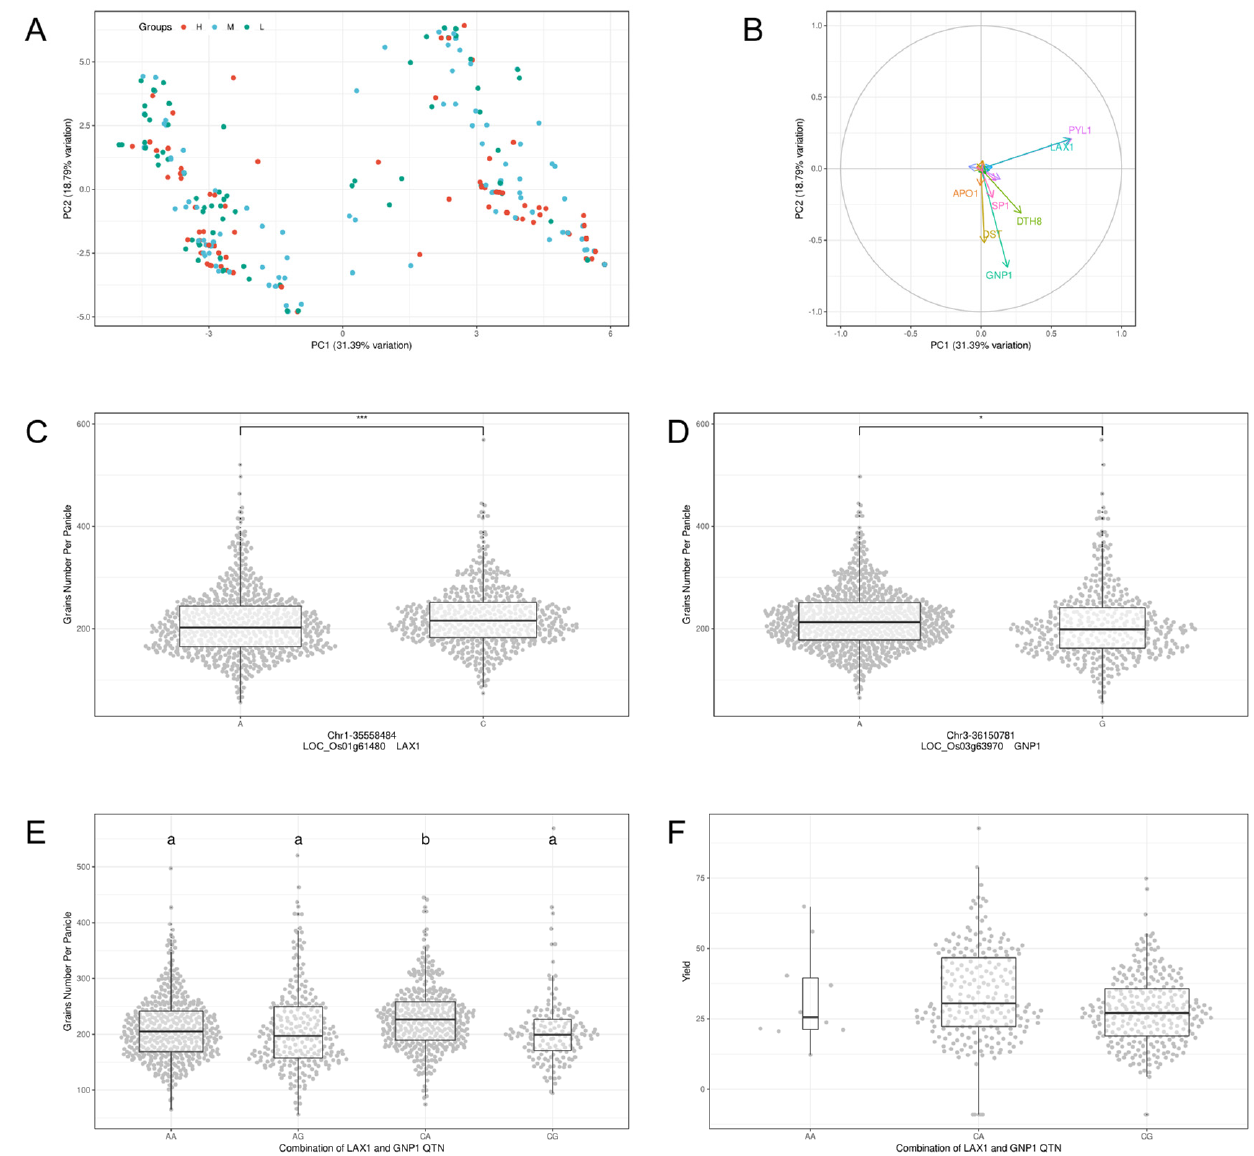
Figure 2. Principal component analysis reveals superior genotype combinations. ( A ) Principal com- ponent analysis of 20 GNPP-related genes with parental genotypes differences in RILs population; ( B ) parental differential gene loadings for principal component 1 and principal component 2; ( C ) differences from the QTN of LAX1 for GNPP in the RILs population; ( D ) differences from the QTN of GNP1for GNPP in the RILs population; ( E ) QTN combination of LAX1 and GNP1 affecting GNPP in the RILs population; ( F ) effects of QTN combination with LAX1 and GNP1 on the yield of HAU533 rice materials. * indicates p value < 0.05. *** indicates p value < 0.001. Different alphabets denote significant difference and vice versa. Table 2. Score of parental genotypes in the mean of grains number per panicle in five years.